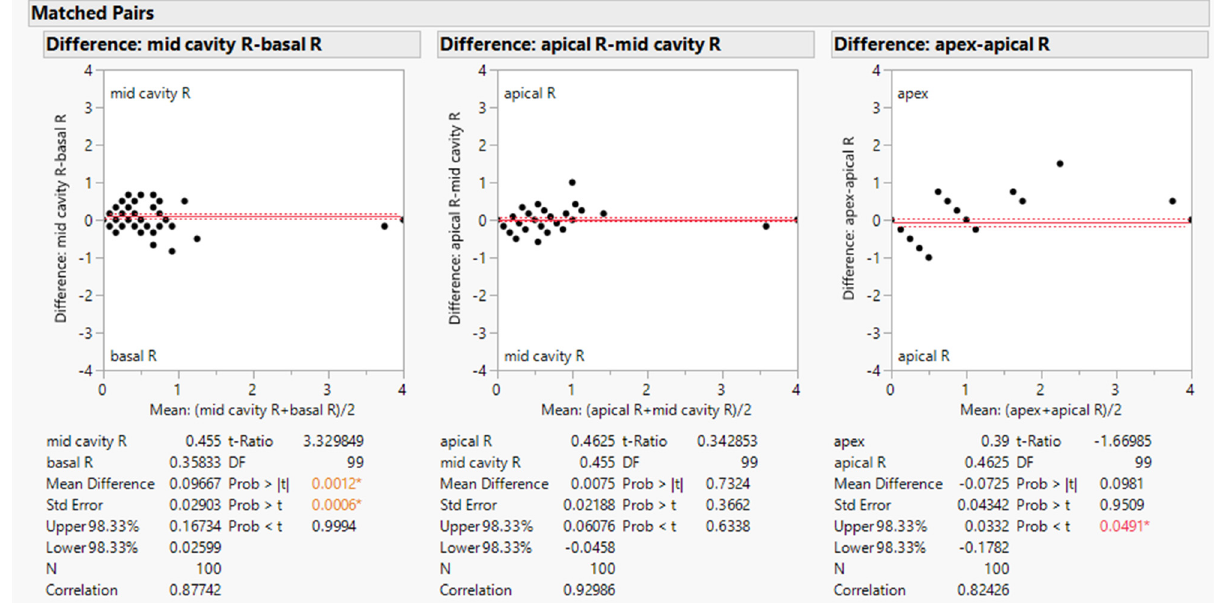
Figure 6. Result of paired two-sided t-test. The p -values lower than 0.05 are shown in red color with a star